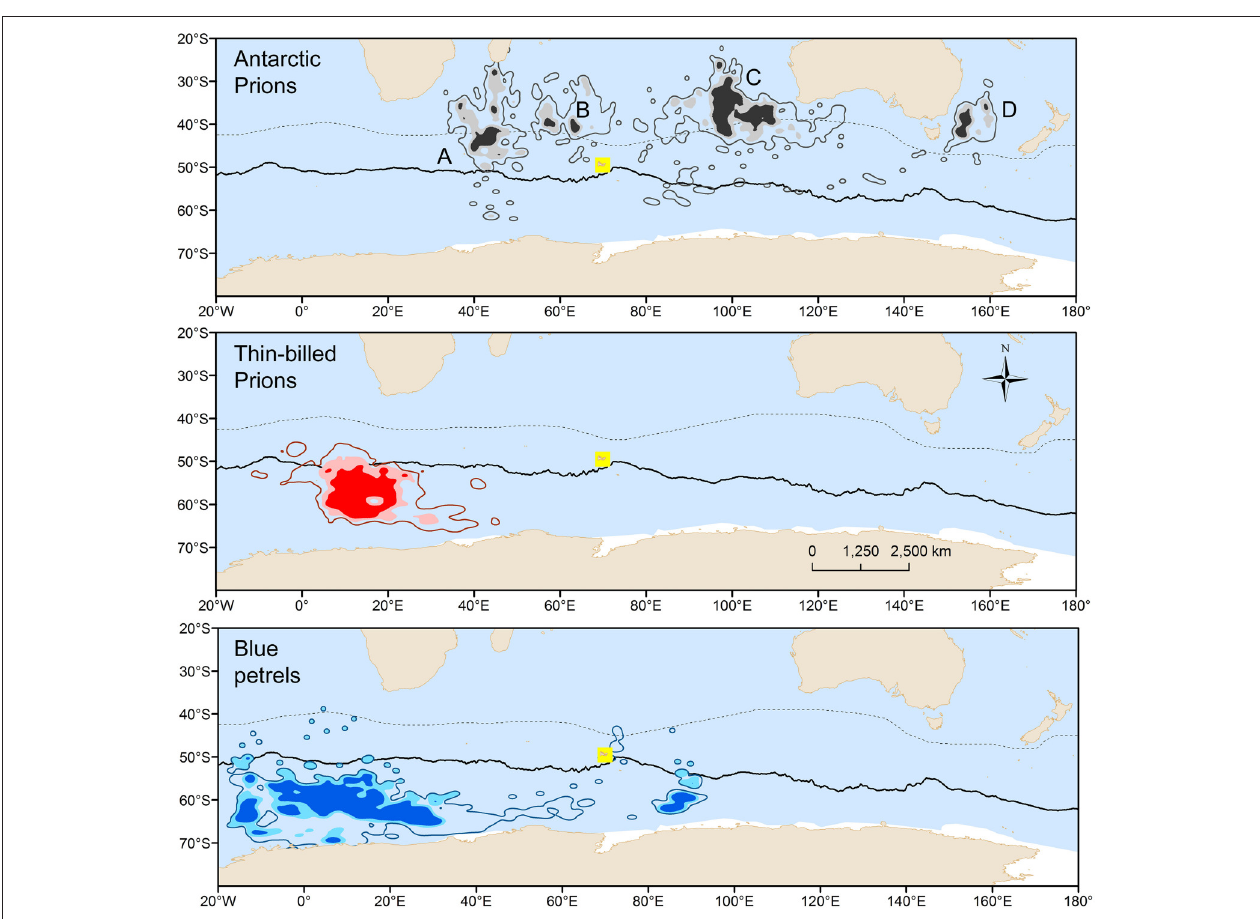
FIGURE 4 | Density contours resulting from kernel estimation of geolocation patterns of Antarctic (gray) and thin-billed (red) prions and of blue petrels (blue) during molt of flight feathers. Darker and lighter tone areas show the 75 and 90% location densities of the core molt area, i.e., according to the 75% onwater molt activity criterion, while the contours show the 90% location densities of the extended molt area, calculated using the 50% onwater molt activity criterion. A, B, C, and D refer to the molting distribution of three, one, six, and one Antarctic prions, respectively. Continuous and dashed lines refer to the Antarctic Polar Front and Subtropical Front,